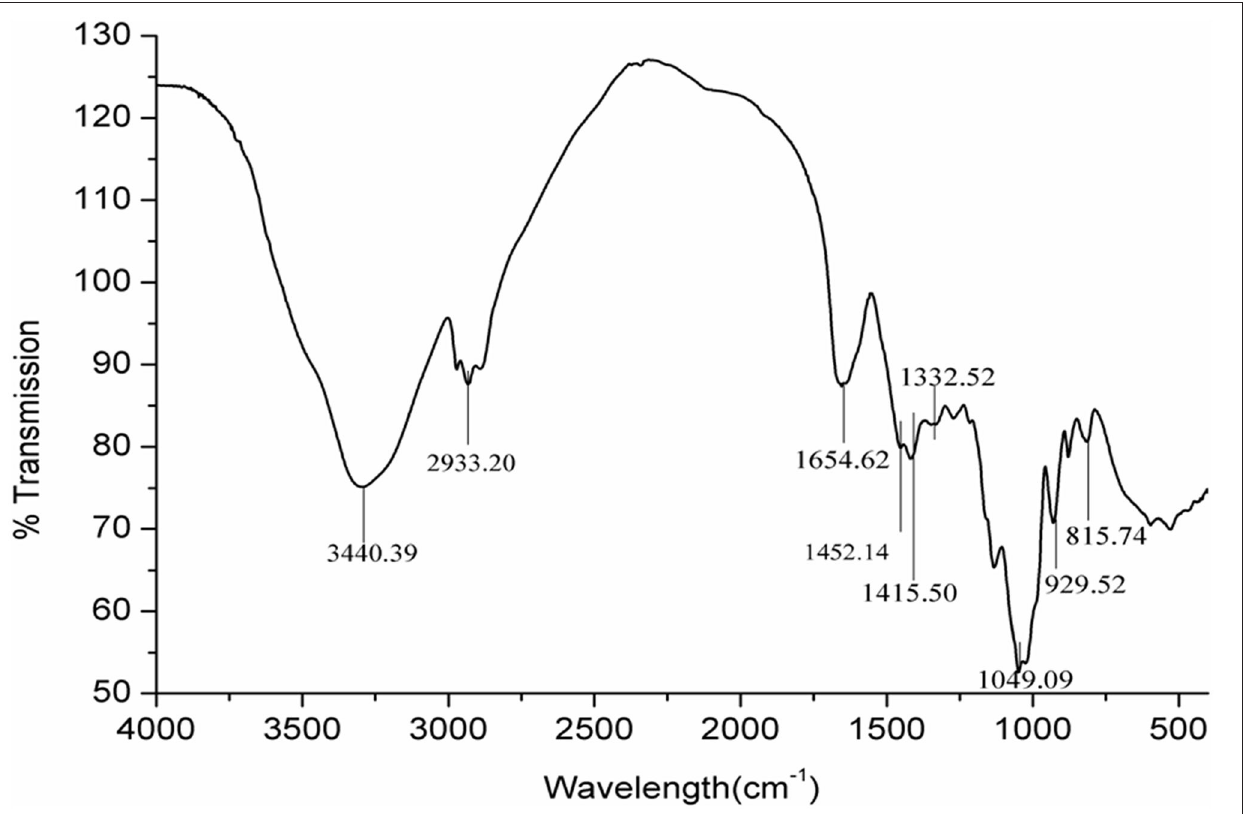
FIGURE 2 | FTIR spectra of the GPs from